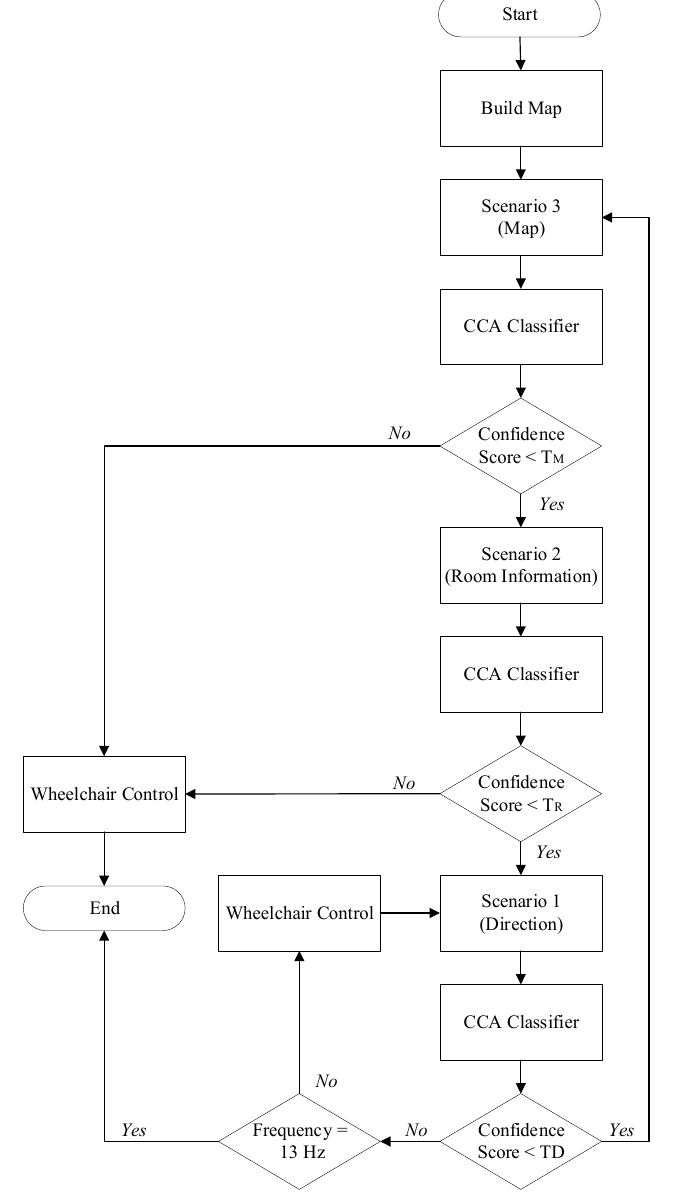
Figure 1. The architecture for this study. Subjects select one of the three scenarios for automatic interactive control. EEG signals are acquired by participants using one of the scenarios. When the data are collected, a CCA classifier detects the target. Analyzed EEG signals are then translated to commands to control the electric wheelchair.